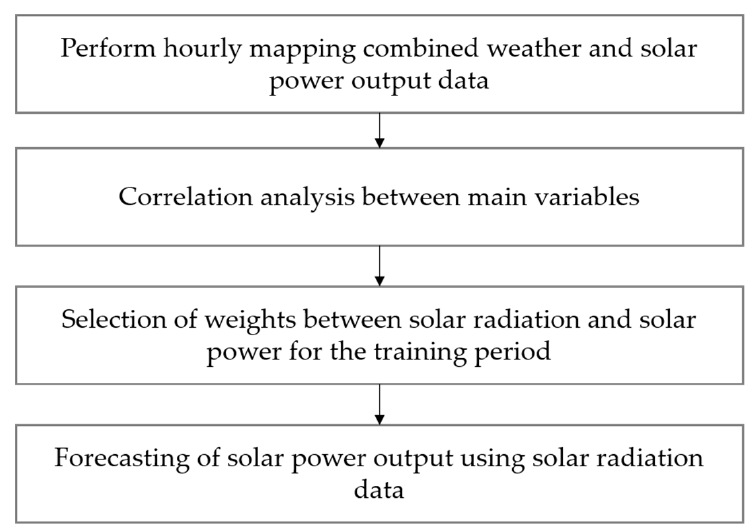
Figure 5. Algorithm for the hourly regression forecasting model.